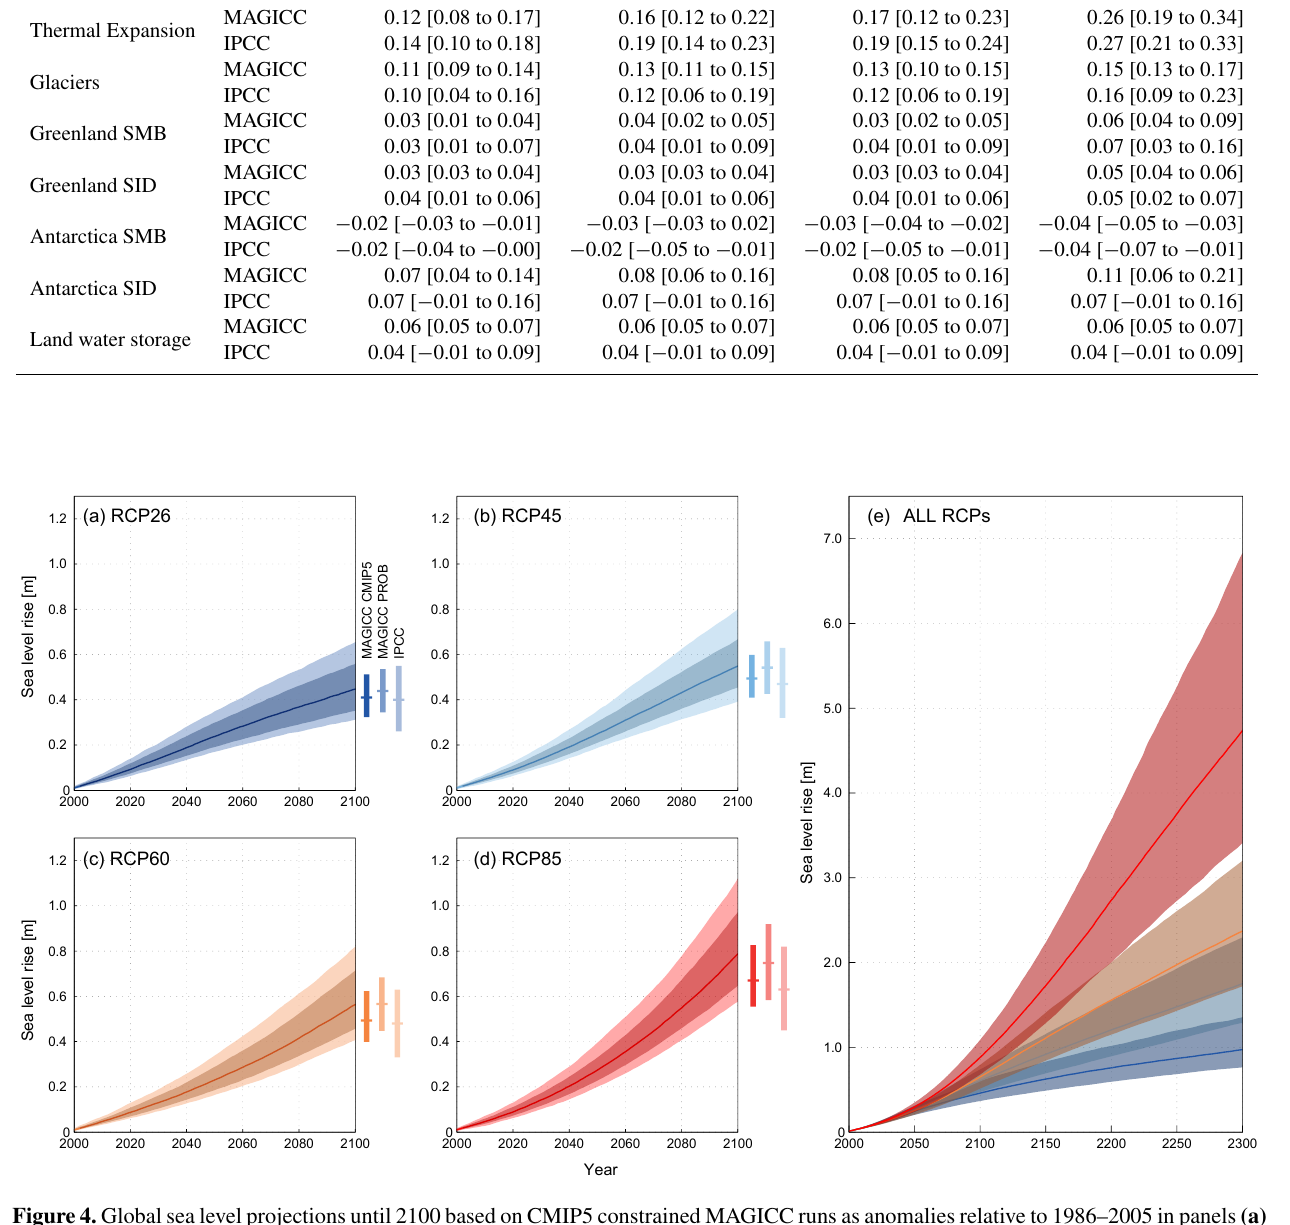
Figure 4. Global sea level projections until 2100 based on CMIP5 constrained MAGICC runs as anomalies relative to 1986–2005 in panels (a) to (d) ; 90% ensemble range in light colors, 66% ensemble range in darker colors, median as solid line. The 2081–2100 anomalies with respect to 1986–2005 as vertical bars for CMIP5 constrained MAGICC setup (MAGICC CMIP5), historically constrained probabilistic MAGICC setup (MAGICC PROB), and IPCC reference projections. The 2300 sea level projections in panel (e) are showing 66% ranges for all RCP extensions based on MAGICC PROB; median estimates as solid